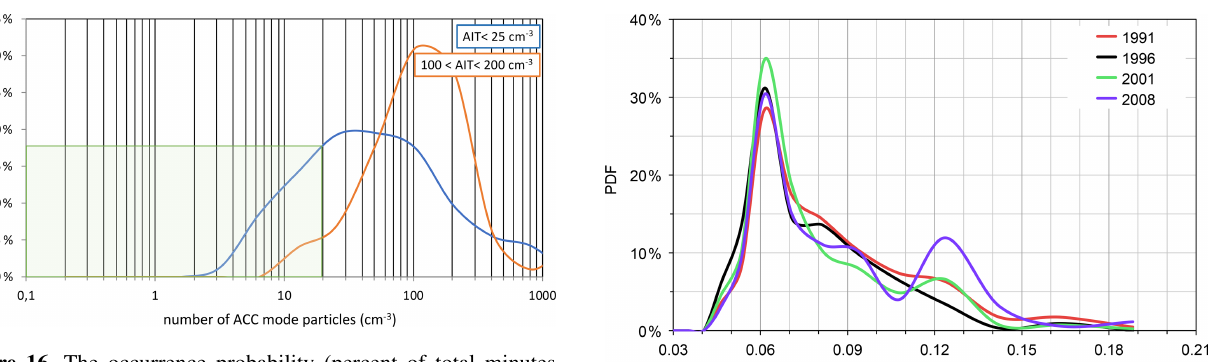
Figure 16. The occurrence probability (percent of total minutes of observations) for two classes of Aitken (AIT) mode concentra- tions, i.e. AIT < 25cm − 3 and 100 < AIT < 200cm − 3 . On the x axis is the number of accumulation (ACC) mode particles in cu- bic centimetres. The statistics are calculated for four different ex- peditions in the high Arctic in the summers of 1991, 1996, 2001 and 2008. Further details on the quality and data processing of the aerosol size resolved measurements are available in Heintzenberg and Leck (2012).